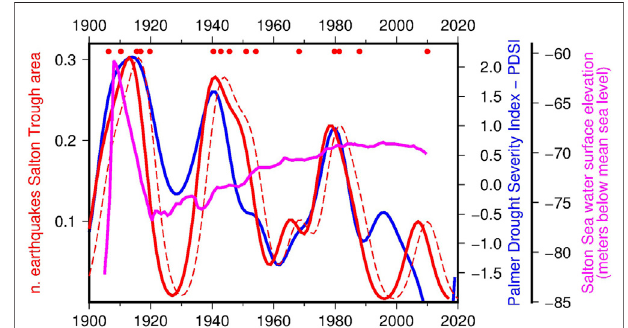
FIGURE12| TimedensityofMw ≥ 5.7earthquakesintheSaltonTrough area compared with the smoothed curve of PDSI averaged over the climate zones6and7andthewatersurfaceelevationoftheSaltonSea(metersbelow mean sea level). For the earthquakes they are reported both the original density curve(reddashed line)and thesamecurveanticipated by3 years (red continuousline)inordertomaximizesthecorrelationwithPDSI(seetheresults for the data set 12 in Table 1 ). The dots indicate the time of occurrence of the 15 earthquakes.